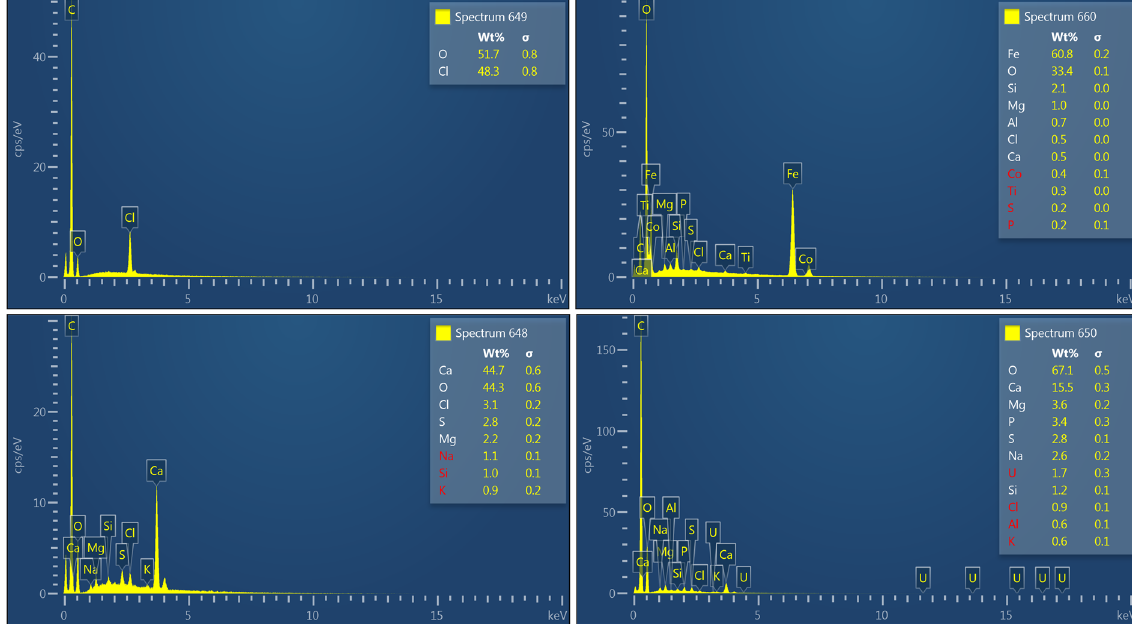
Figure 13. SEM-EDS spectrums at locations in Figure 12. Elements in red are below the SEM-EDS detection limit. Additional distinct locations of high fission-track density at GJAST − 14 include ura- nium inherent in mineral grains. An example of this is a titanium oxide grain associated with uranium fission tracking (Figure 14). The fission-track density is resolved enough to show the lack of uranium within the quartz that is part of the whole grain. Since the thin